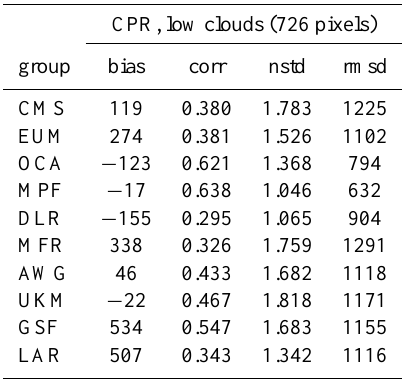
Table 12. Same as Table 11, but for CPR. For clarification, the iden- tification of low clouds is done with the CALIOP CTH. Pixels are taken into account, for which all SEVIRI algorithms as well as the CALIOP and CPR retrieval provide CTH values. The mean CTH retrieved by CPR is 1996m and the standard deviation is